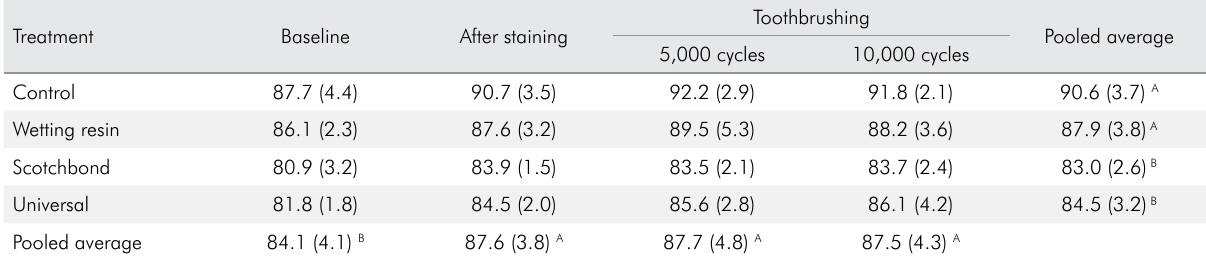
Table 5. Mean and standard deviation (SD) of opacity values according to treatment and assessment time intervalsa.